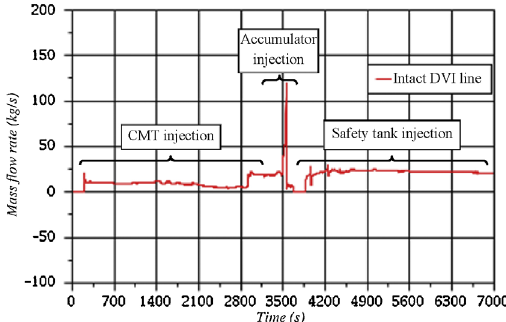
Fig. 22. Injection mass fl ow through intact DVI line (kg/s).